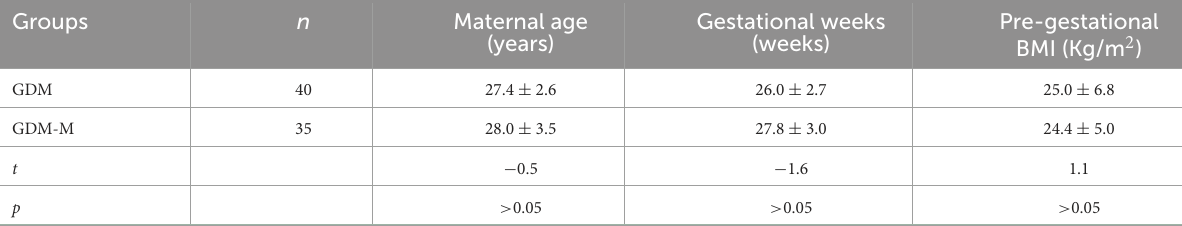
TABLE 1 Baseline variables in two groups ( x ± s